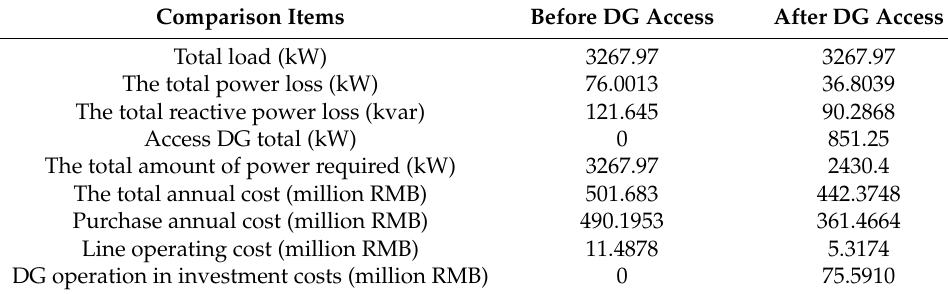
Table 5. Comparative analysis of before and after DG